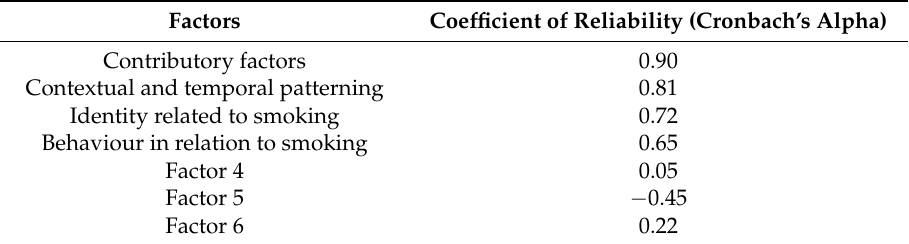
Table 10. Coefficient of reliability of the factors (n =